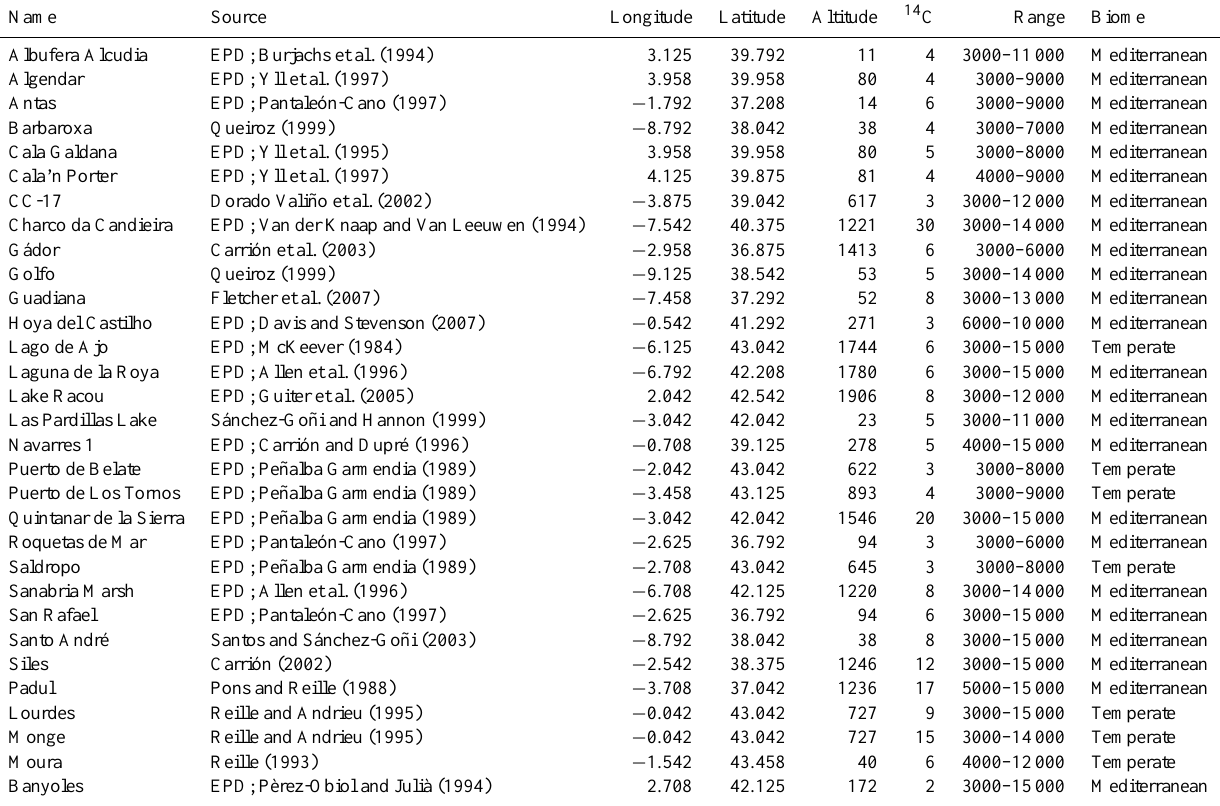
Table 1. Origin and description of the data sources of fossil pollen used to reconstruct the climate in the Iberian Peninsula. Source is either the European Pollen Database (EPD) or author contribution. Longitude and latitudes correspond to the centroid of the nearest cell to the site and altitude as extracted from WorldClim data set, all at 5 (cid:48) spatial resolution. Each site has information about the number of 14 C dates available, the temporal range covered (see also Fig. 1 for the spatial distribution) and the respective biome following the classification of Olson et al.